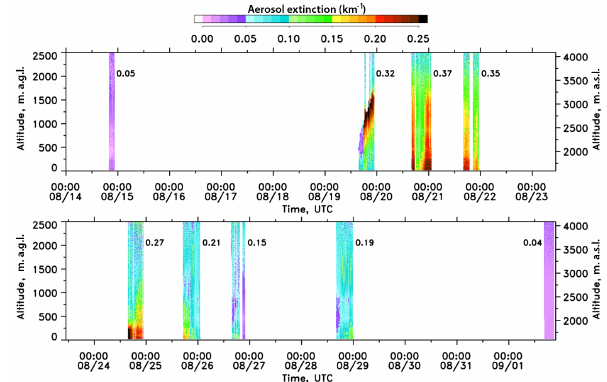
Figure 11. Aerosol extinction profiles at 294nm observed with the TOPAZ lidar on 9 days during the smoke pollution episodes. The numbers next to each day’s observations represent the daily mean AOD from the surface up to 2.5kma.g.l. computed from the lidar